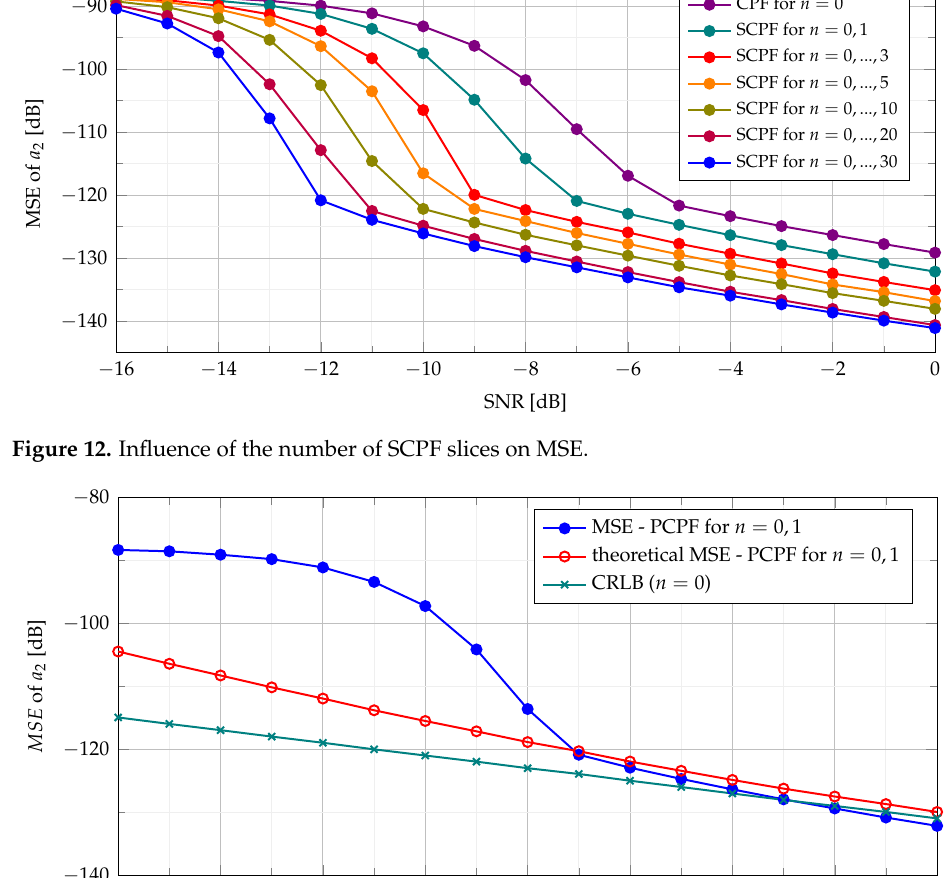
Figure 13. Theoretical and measured MSEs of the PCPF for n =